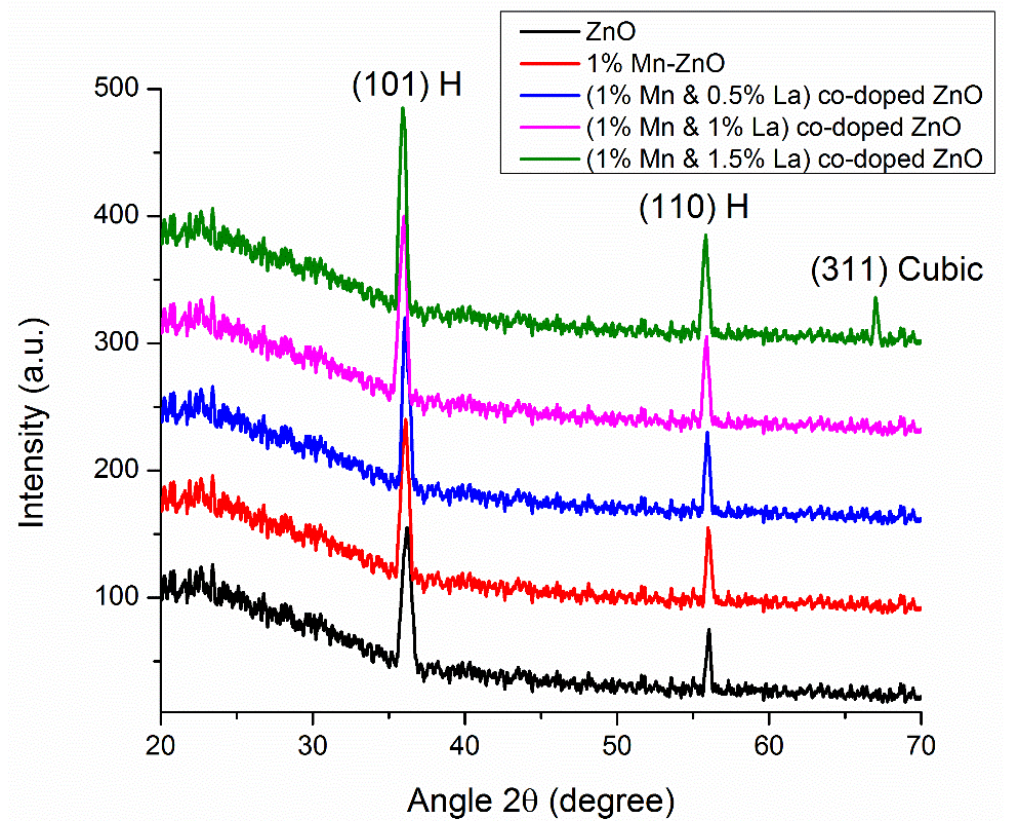
Figure 1. XRD pattern of undoped ZnO thin films and ZnO thin films co-doped with Mn and La. When the La doping concentration was increased to 1.5%, three diffraction peaks occurred at 2 θ angles of 35.93 ◦ , 55.88 ◦ , and 66.99 ◦ , corresponding to (101), (110), and (311) crystal planes. The first two peaks correspond to (101) and (110) and indicate a hexagonal structure (card no. 36-1451), but the peak corresponding to (311) reveals a cubic phase structure of ZnO. When 1.5% La is doped into 1% Mn-ZnO, La atoms cannot be accom-